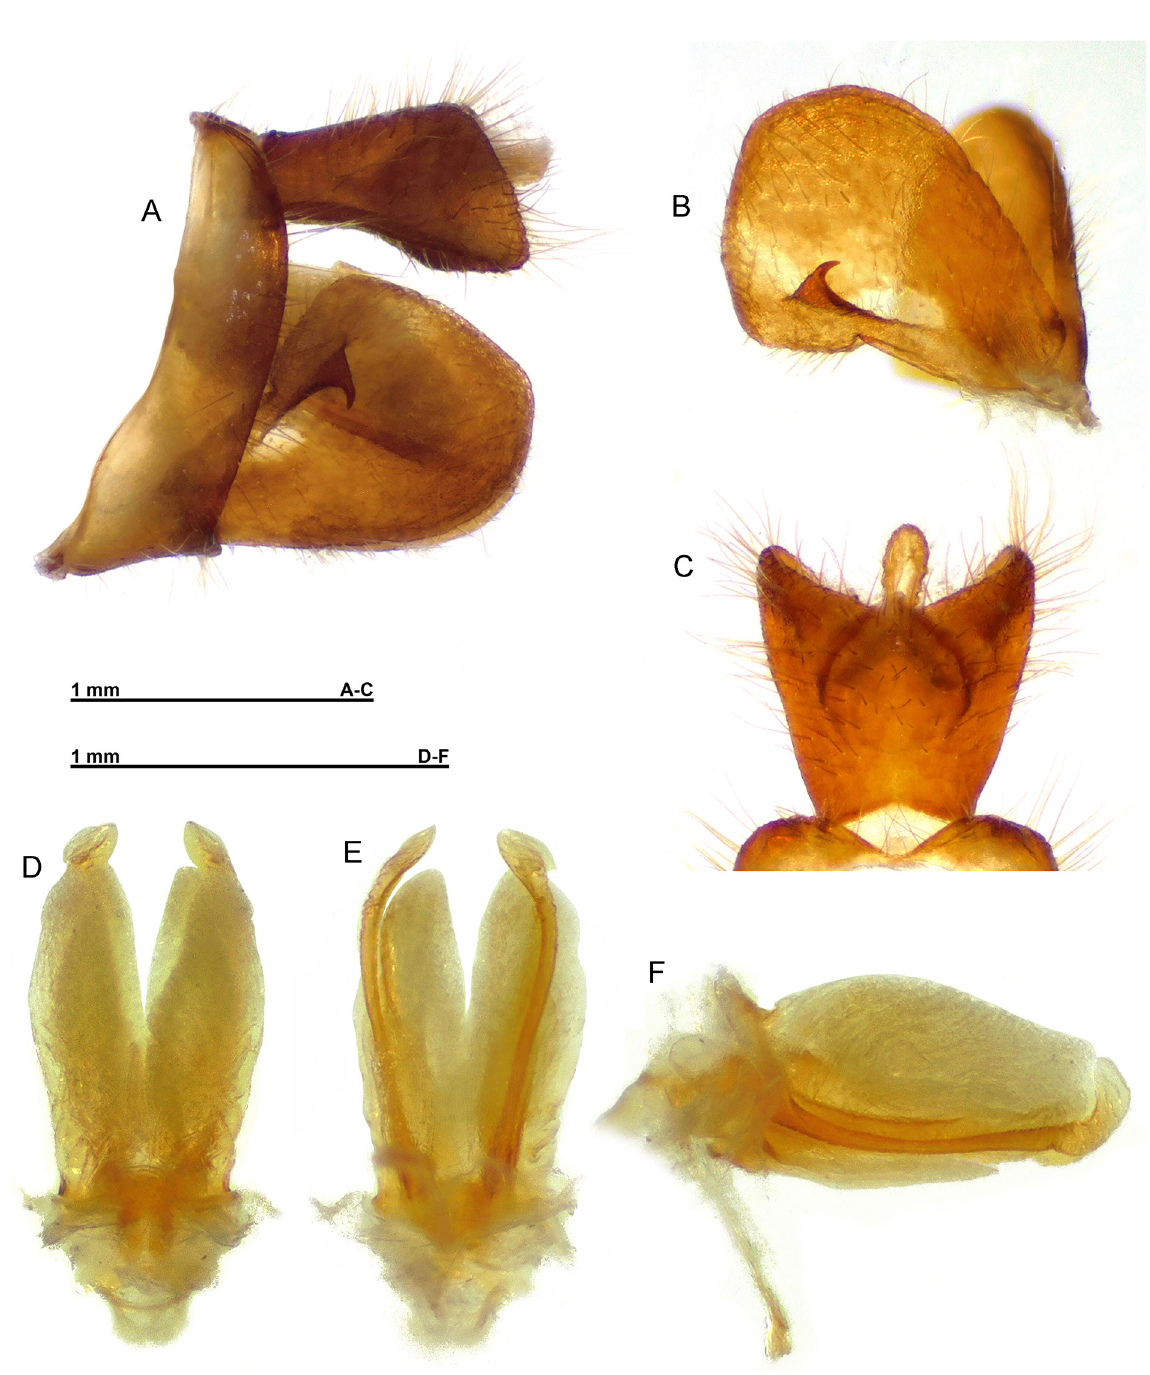
Fig. 5. Limois kikuchii Kato, 1932, Manchuria, K. Kikuchi leg., RBINS, male genitalia. A . Left lateral view (except phallic complex). B . Gonostylus. C . Anal tube, dorsal view. D . Aedeagus, dorsal view. E . Aedeagus, ventral view. F . Aedeagus, left lateral view. Photographs by J.